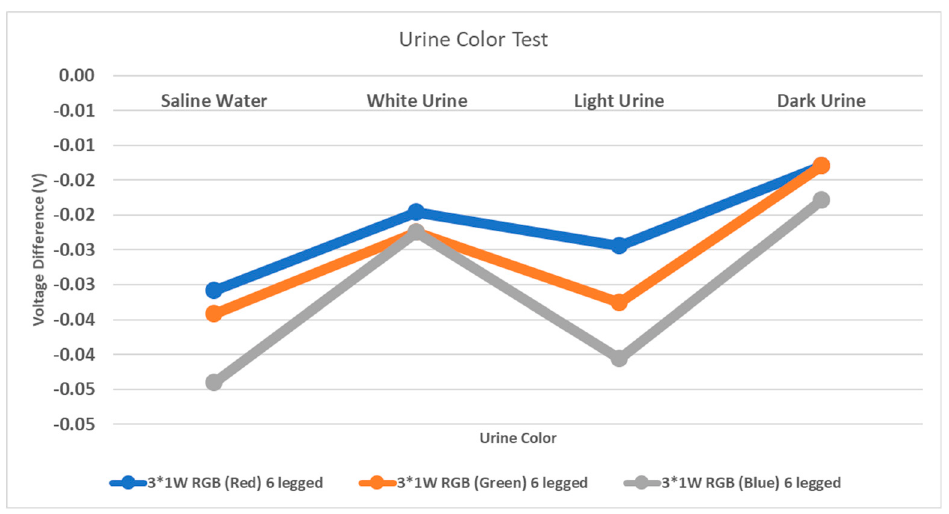
Figure 11. Urine Colour Test.